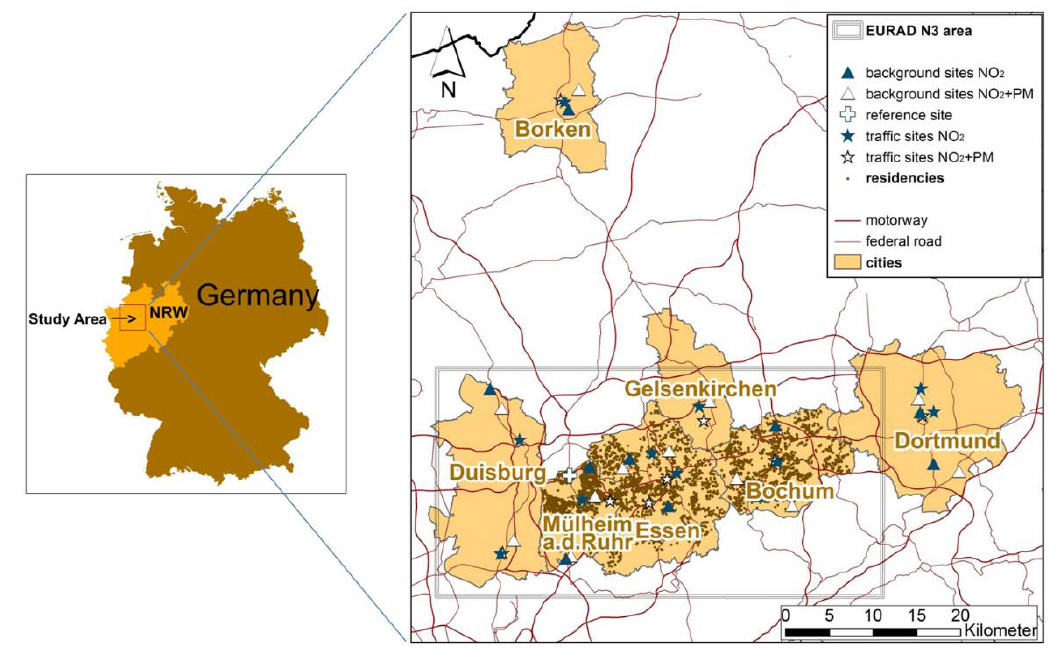
Figure 1. Study area, residences, and monitoring sites.